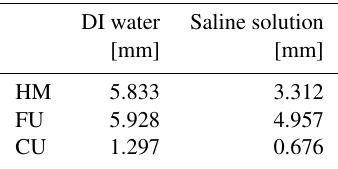
Figure 8. Evaporation and salt precipitation patterns for (a) HM – homogeneous mixture of the glass beads, (b) FU – with the fine glass beads at the upper levels, and (c) CU – with the coarse glass beads at the upper levels. Numbers at the bottom indicate time length of evaporation. Top and bottom of the blue arrows indicate the upper and lower boundaries of the saturated zones, respectively. The orange ovals mark locations of salt precipitation. Table 2. Maximal values of standard deviation for cumulative evap- oration